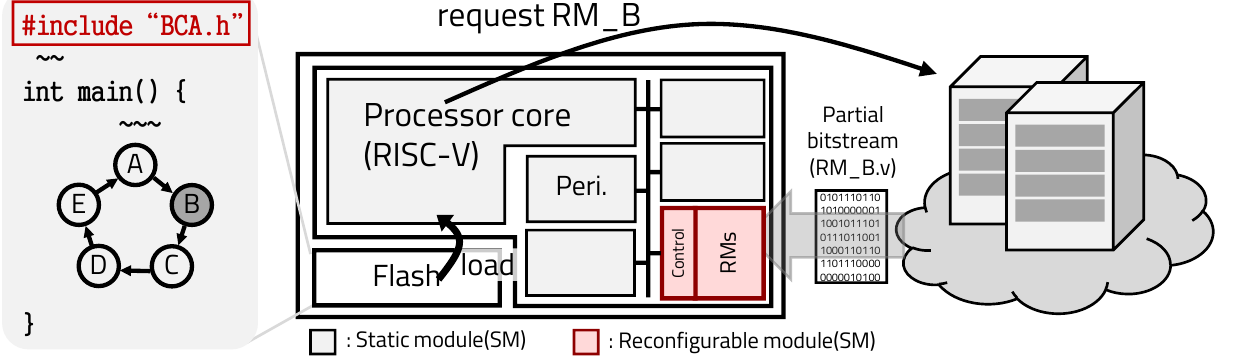
Figure 4. mIoT edge device